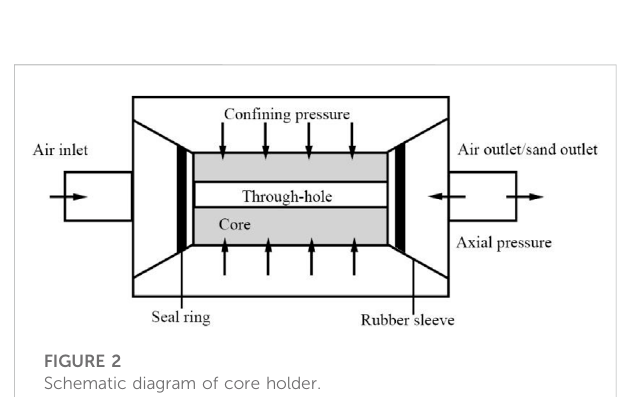
FIGURE 2 Schematic diagram of core